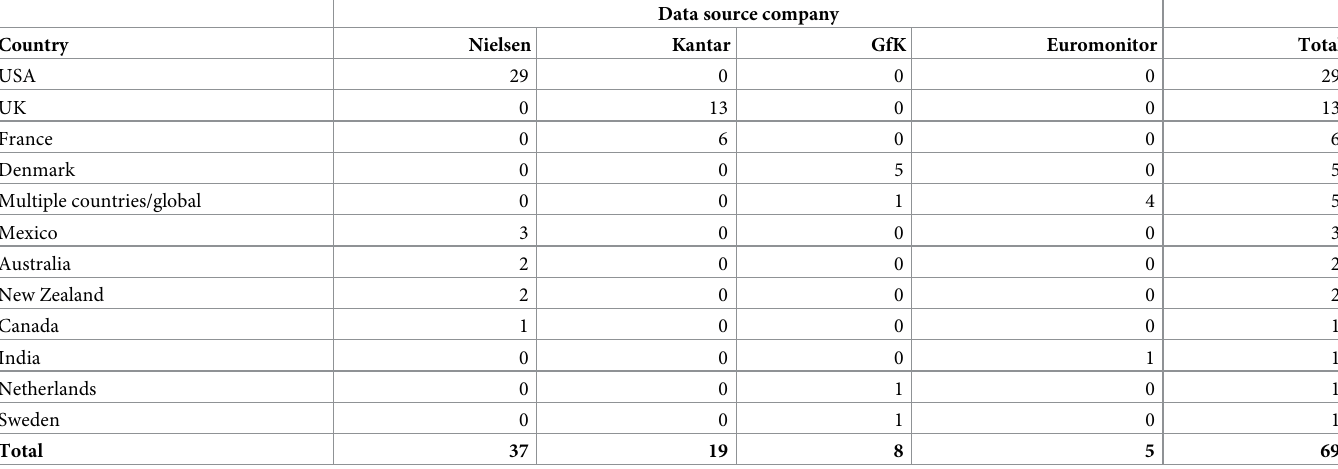
Table 1. Number of papers published that use food sales data by source company and country of research.